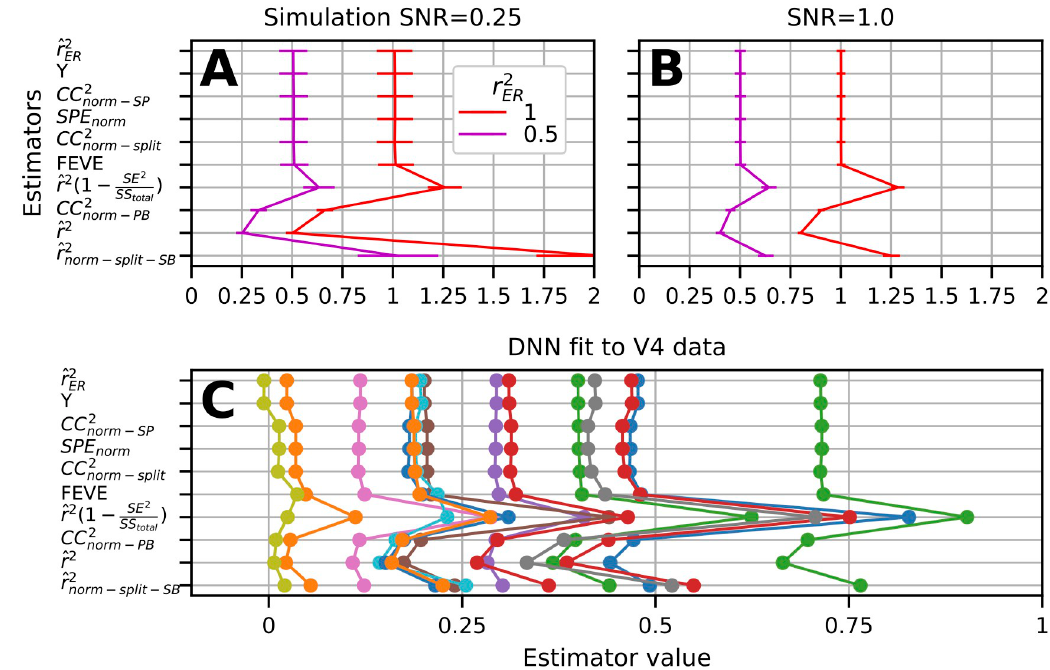
Fig 4. Comparison of ^ r 2 with published estimators of r 2 on the basis of simulated and real data. (A) Low SNR (0.25) ER ER simulation where estimators on vertical axis are sorted from top to bottom by smallest MSE with respect to estimating r 2 Traces show mean and SD of each estimator. (B) Same simulation at higher SNR (1.0) but same m , n . (C) Estimated fit of DNN to V4 data by ^ r 2 and published estimators. Each trace is the estimated fit of the model for one neural recording. ER